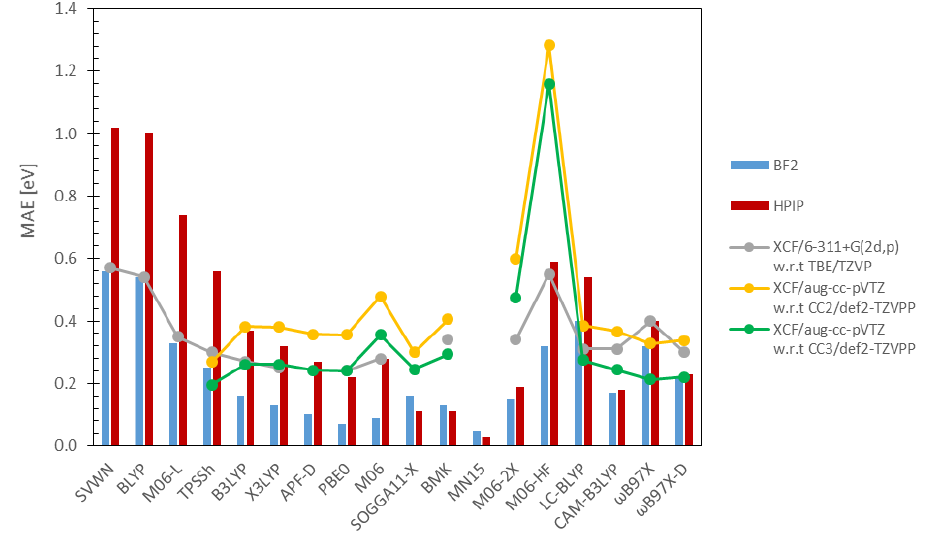
Figure 3. Comparison of DFAs predictive power; data presented in columns concern vertical energies calculated in this work, while the information displayed as “lines” relates to literature data—grey is the Thiel set; yellow, 104 singlet ES [126]; and green, 41 ES of small- and medium-sized organic molecules